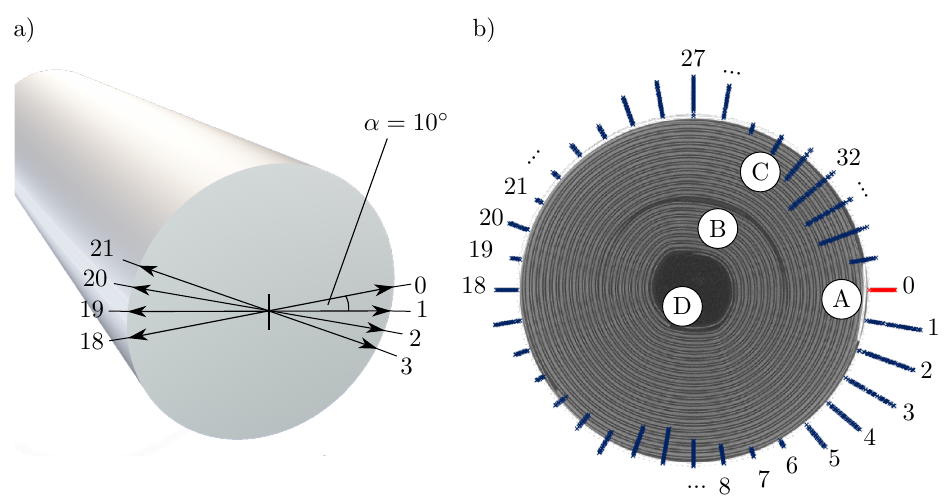
Figure 4. ( a ) Schematic drawing of a cylindrical Li-Ion cell, marked with the points measured in the light band micrometer, which are located at an angle of α = 10 ◦ to each other. The start position from the measurement (position 0) corresponds to the position of the negative current collector tab, which was marked in the CT (marked A in Figure 4b; ( b ) 100-fold amplified expansion of the cell thickness in steps of ∆ SoC = 2.5% at the corresponding positions including a CT image of the cell to assign the corresponding positions on the cell circumference. A marks the negative current collector tab, B the positive current collector tab. C highlights one of two spots, where a small gap between the jelly role and the housing is located, where the jelly role is not pressed against the housing. D marks the end of the jelly